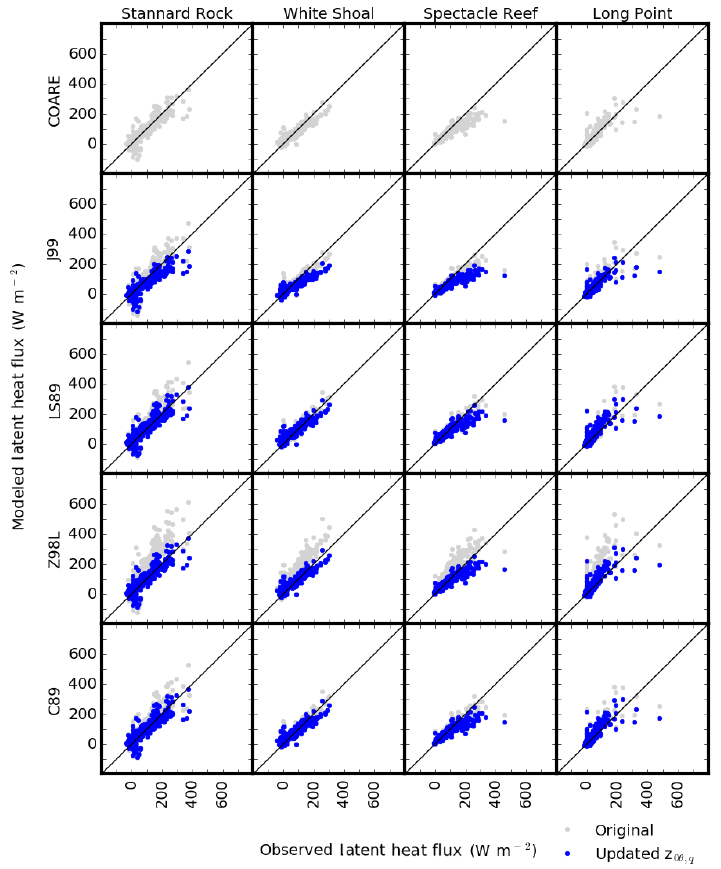
Figure 9. The same as Fig. 8, but for sensible heat flux ( H ).